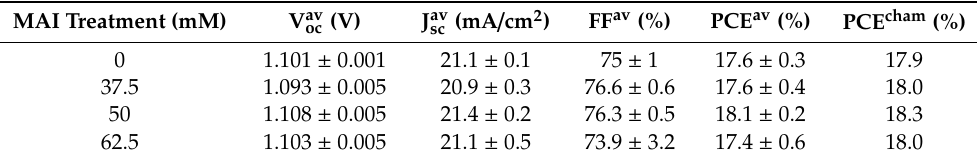
Table 2. Perovskite solar cells’ (PSCs) photovoltaic parameters of the MAPbI 3 PSCs with MAI treatment. For each condition, the J sc , V oc , FF, and PCE average values were measured in backward scanning mode. PCEs for the champion PSCs are also reported.